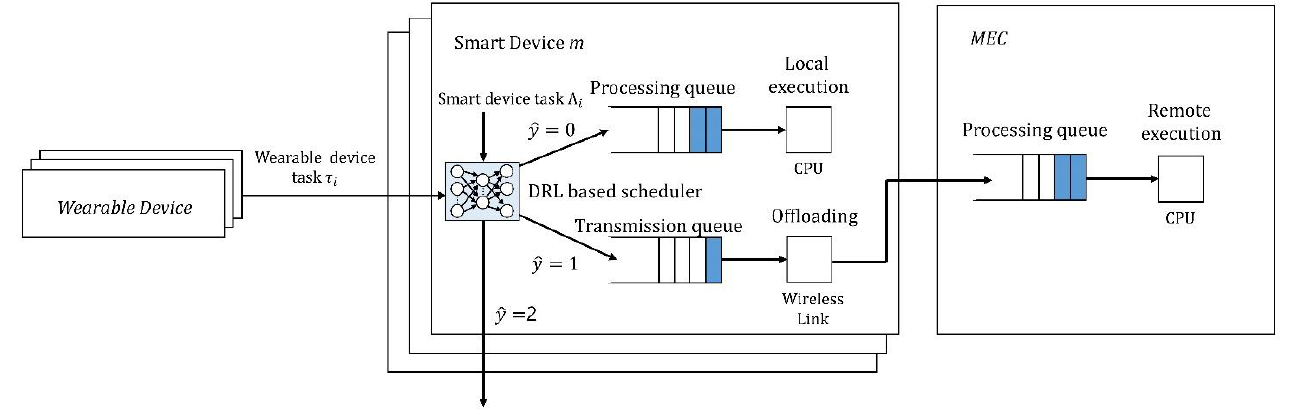
Figure 4. Illustration of the structure of the smart device with a DRL-based scheduler.